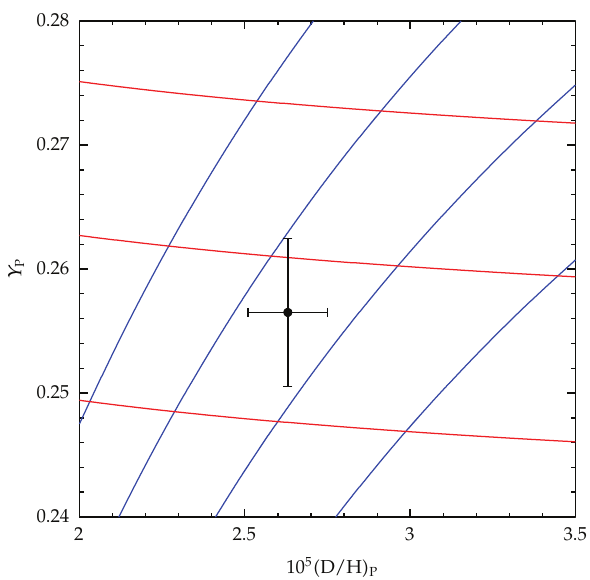
Figure 3: Contours of constant values of Δ N ν (cid:3) red (cid:4) and η 10 (cid:3) blue (cid:4) in the Y P - y DP plane. From bottom to top the red curves correspond to Δ N ν (cid:7) 0 , 1 , 2. From left to right the blue curves correspond to η 10 (cid:7) 7 . 0 , 6 . 5 , 6 . 0 , 5 . 5. Also shown (cid:3) filled circle and error bars (cid:4) are the adopted primordial abundances of D and 4 He and their 1 σ